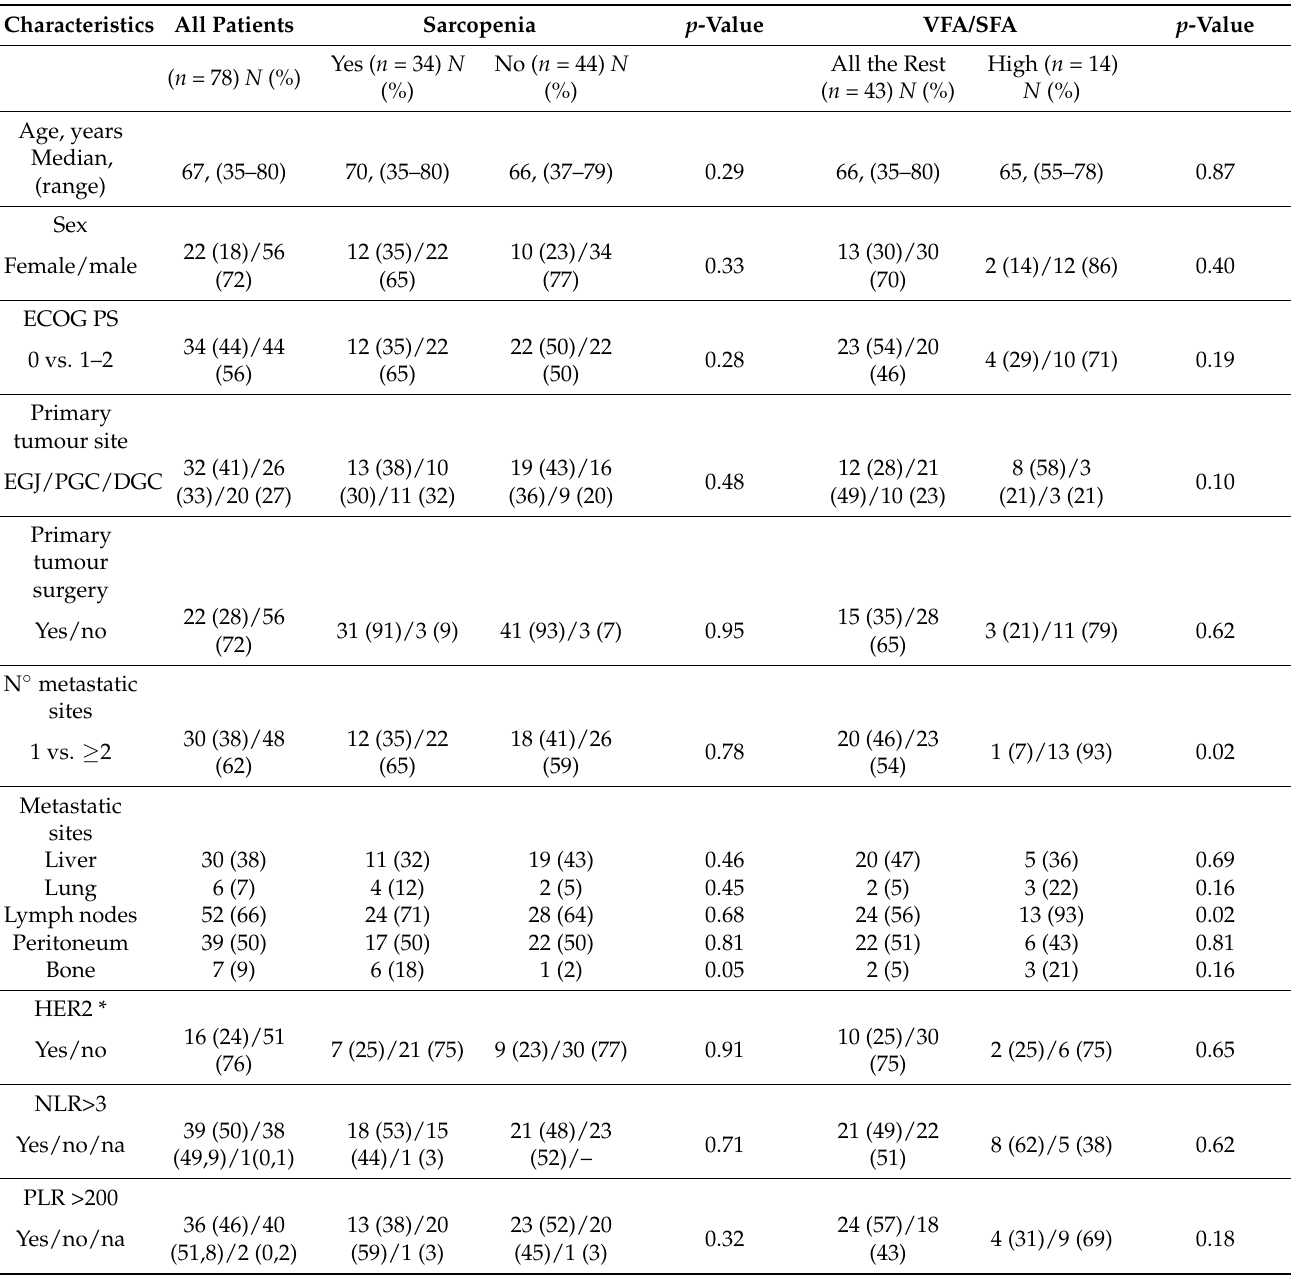
Table 1. Patient characteristics according to loss of muscle mass and abdominal fat